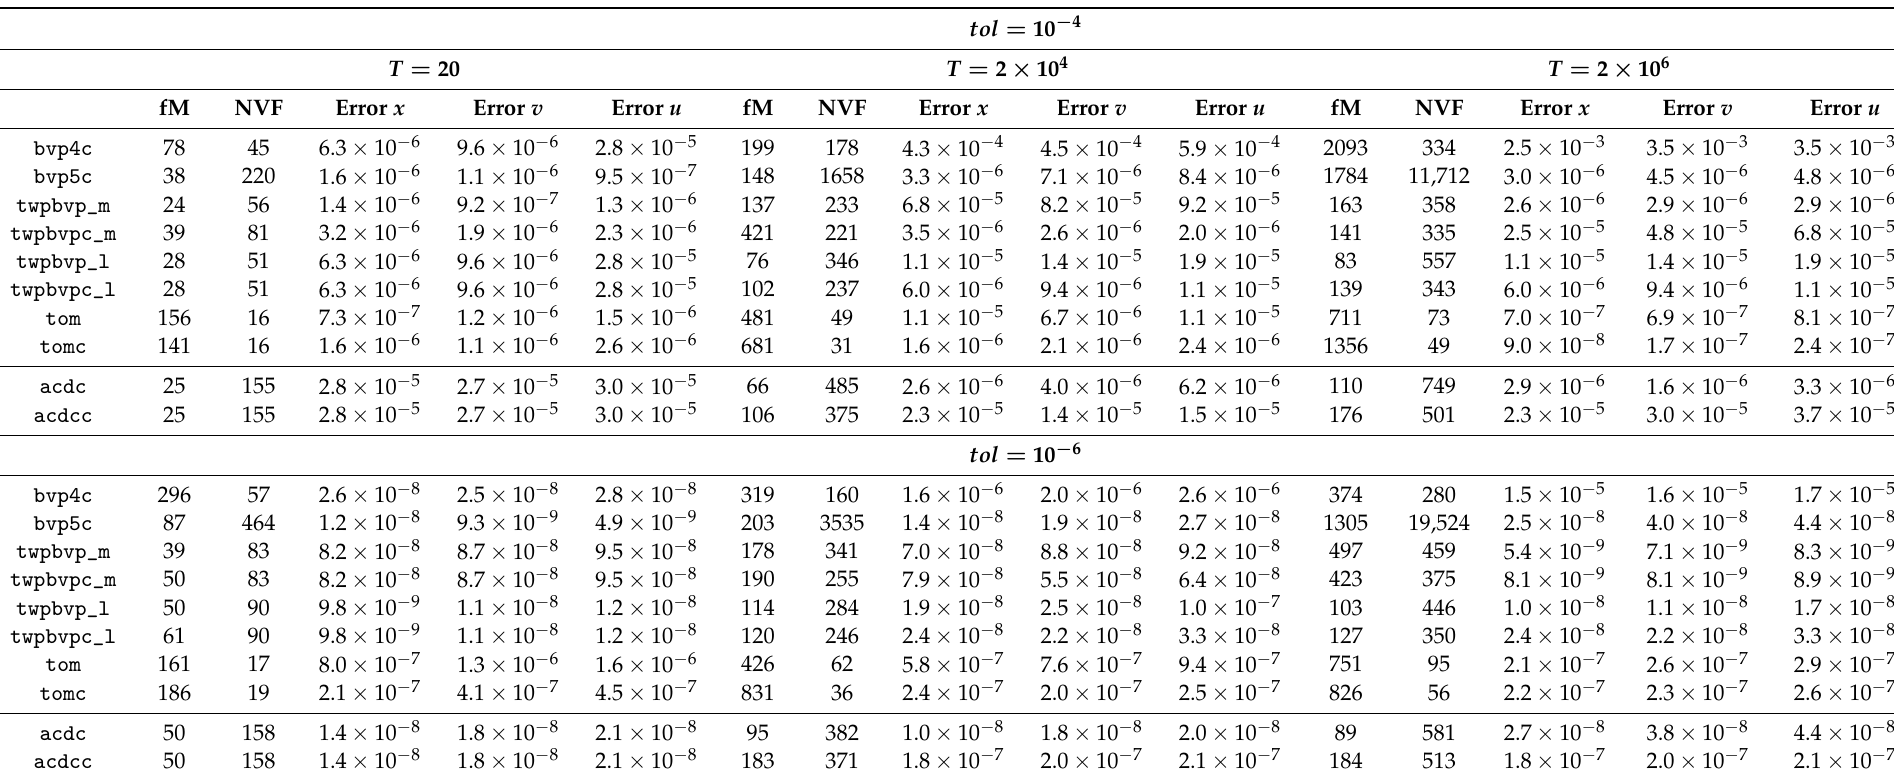
Table 4. Nonlinear Mass spring using the variable τ = t / T , initial mesh with starting mesh with 11 equidistant points and continuation strategy on (cid:101) = 1/ T , final mesh (fM), total number of vectorized function evaluation (NVF) and mixed errors for x , v , u